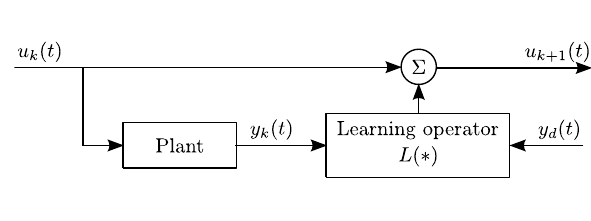
Figure 1: Basic learning